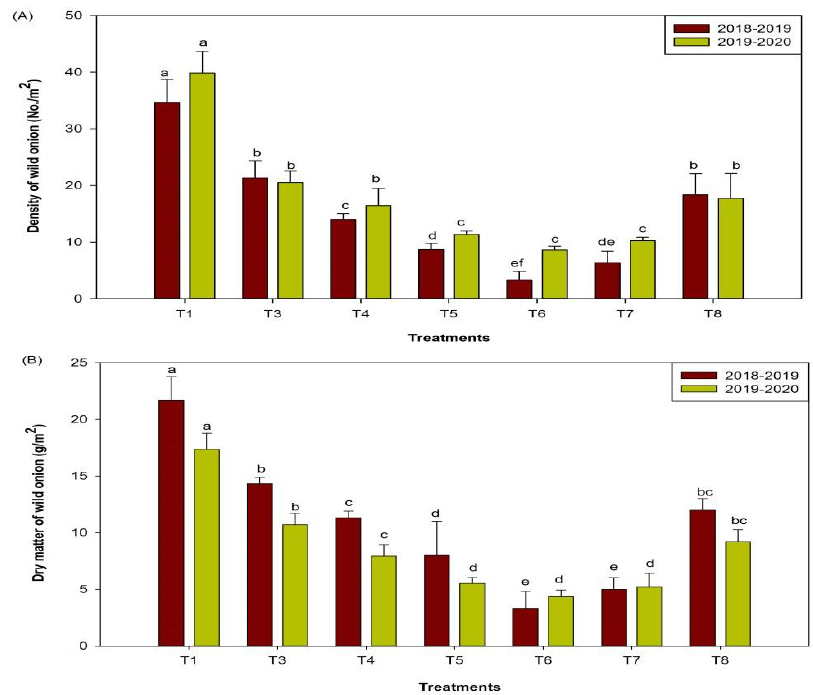
Figure 2. Efficacy of different herbicides on density ( A ) and dry matter ( B ) of Asphodelus tenuifolius. Where, T 1 = weedy check; T 3 = pendimethalin 38.7 CS @ 750 g/ha–PE; T 4 = oxyfluorfen @ 200 g/ha–PE; T 5 = pendimethalin 38.7 CS 500 g/ha + oxyfluorfen 150 g/ha @–PE; T 6 = oxyflourfen @ 200 g/ha 8 DAS–early POE; T 7 = pendimethalin 38.7 CS 500 g/ha + oxyfluorfen @ 150 g/ha 8 DAS–early POE; T 8 = oxydiargyl @ 50 g/ha 20 DAS–POE. Error bars show SD; Fisher LSD method at 95% confidence ( p ≤ 0.05) was used to group information between the mean values of acquired data. Different letters point out significant differences among the treatments in a particular